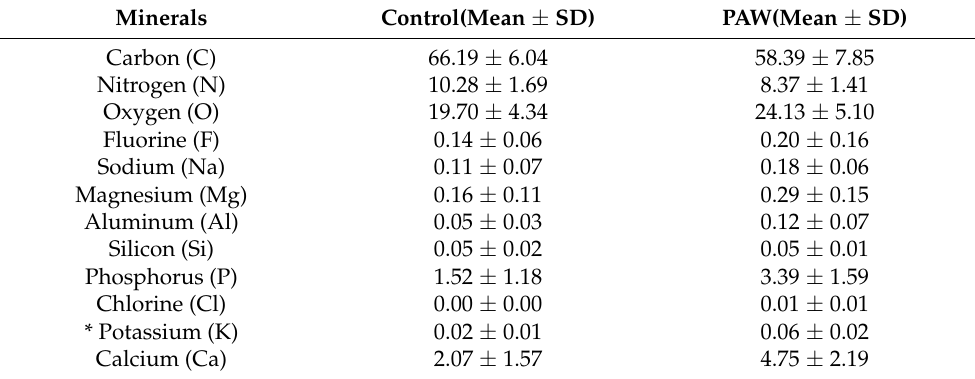
Table 1. Teeth composition—% atoms.